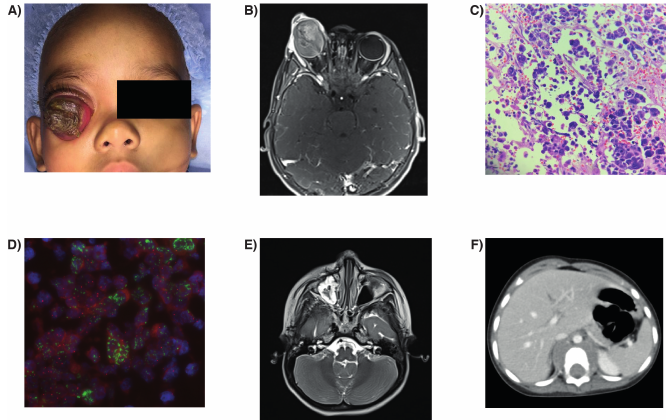
Figure 1. ( A ) Clinical presentation of Patient 1 denoting a fungating mass in the right eye; ( B ) T2-weighted axial MRI at hospitalization showing a gross orbital mass without radiological involvement of the optic nerve and no intracranial extension or metastasis; ( C ) Histopathological findings of the orbital tissue after exenteration. Hematoxylin & eosin stain showing pleomorphic cells, anaplasia, and areas of necrosis; ( D ) Fluorescence in situ hybridization (FISH) of MYCN showing amplification of this gene (red signals) with respect to AFF3 (green signals) as a reference. Original magnification 20x; ( E ) T2-weighted axial MRI after multimodal treatment, including exenteration, adjuvant chemotherapy, and radiotherapy showing a relapsing mass in the maxillary sinus and ( F ) a paravertebral mass with intraspinal